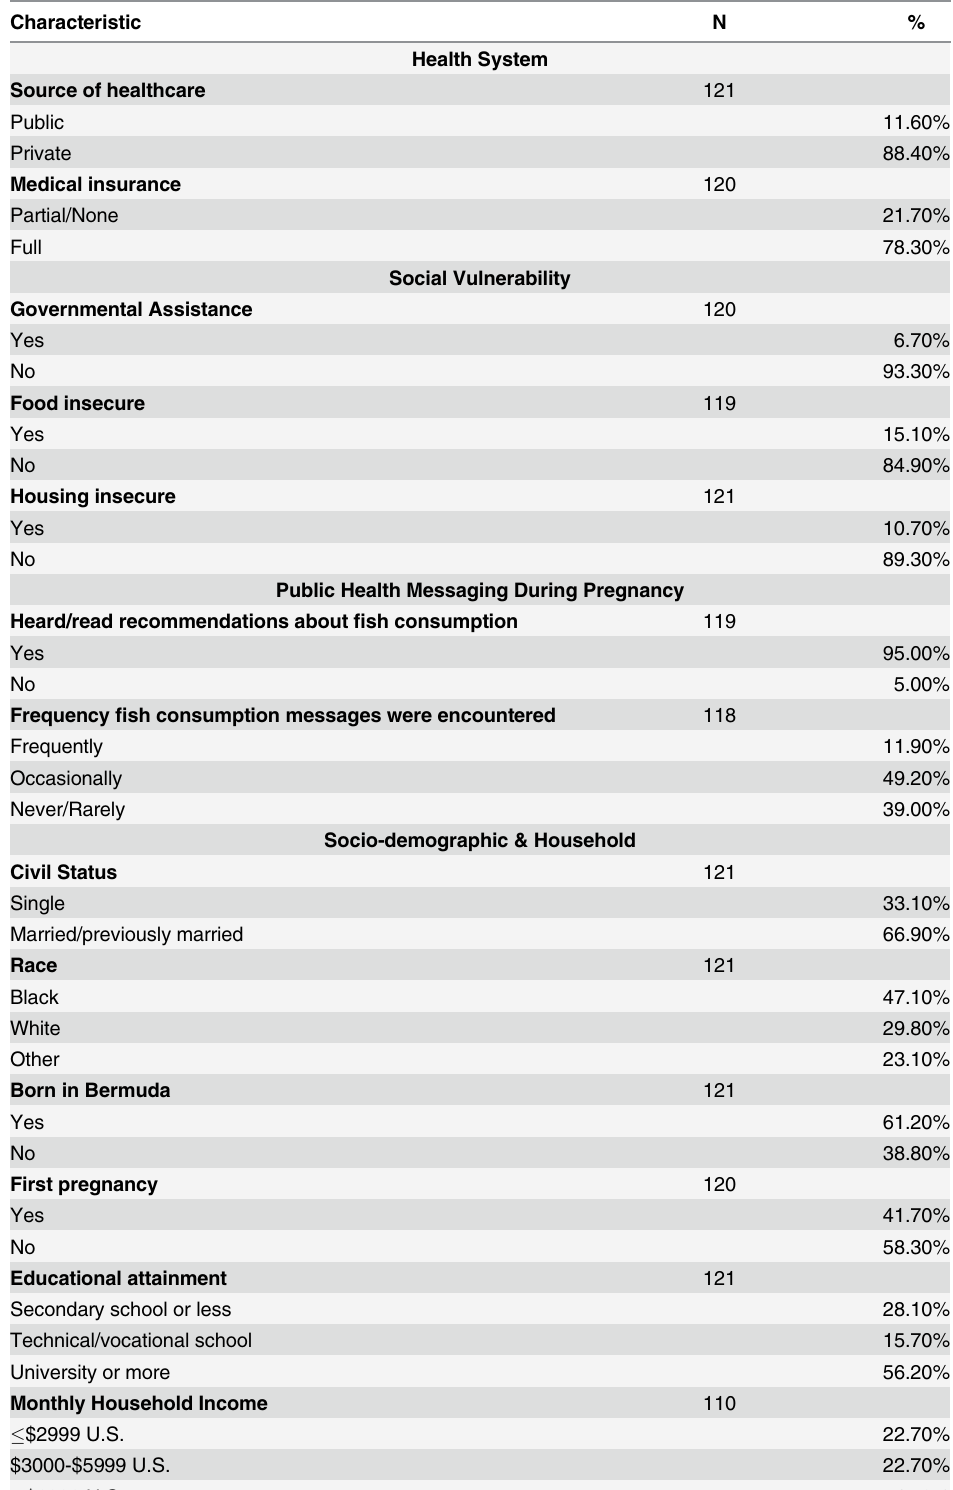
Table 1. Participant characteristics 1,2